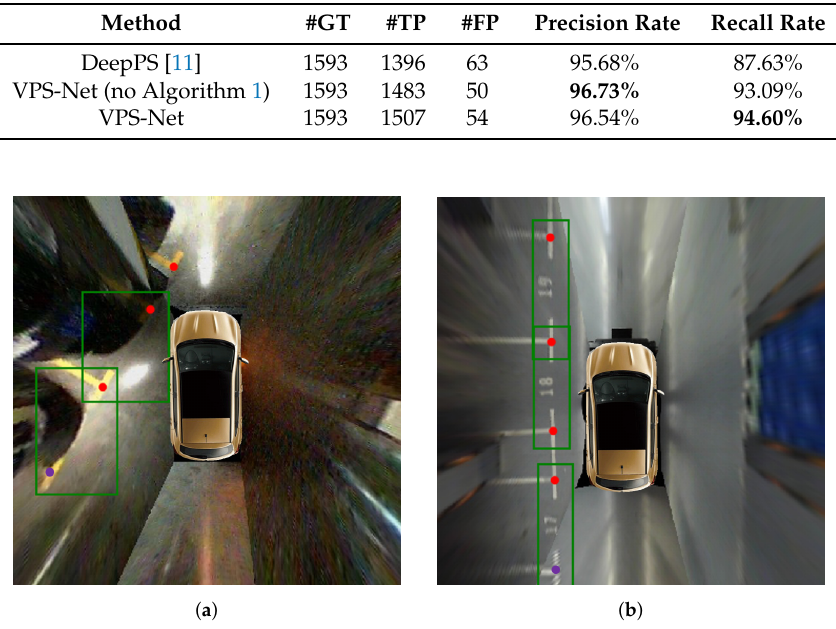
Figure 16. Representative images with the degraded image quality of marking points in the PSV dataset. ( a ) shows the marking point is far from cameras. ( b ) shows the marking point is on the stitching lines. The green bounding box indicates the parking slot head. The red dot indicates the detected marking point, and the purple dot indicates the inferred marking point based on the parking slot